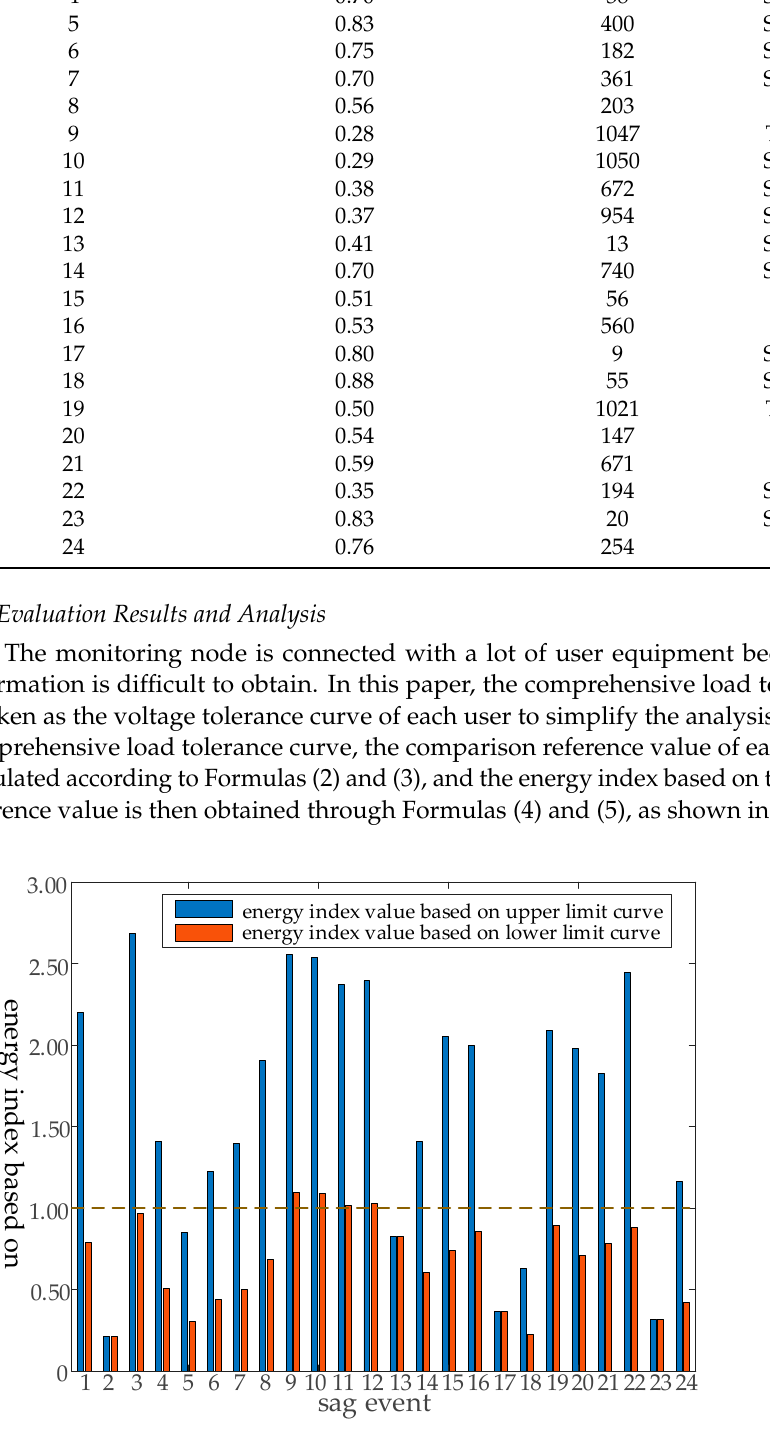
Figure 7. Energy index based on comparison benchmark value.